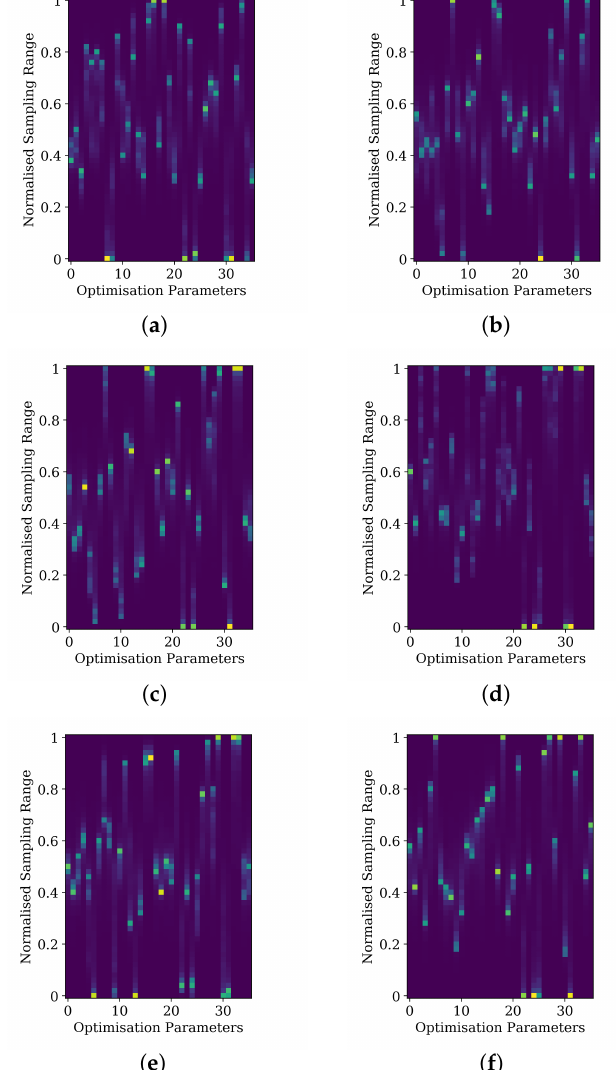
( e ) ( f ) Figure A2. Frequency distribution of the optimisation parameters of the di ff erent IMP runs ( T ∗ ). The normalised sampling range is distributed over 51 bins. ( a ) IMP: T a , ( b ) IMP: T b , ( c ) IMP: T c , ( d ) IMP: T a,b,c ( e ) IMP: T b,c , ( f ) IMP: T a,c .